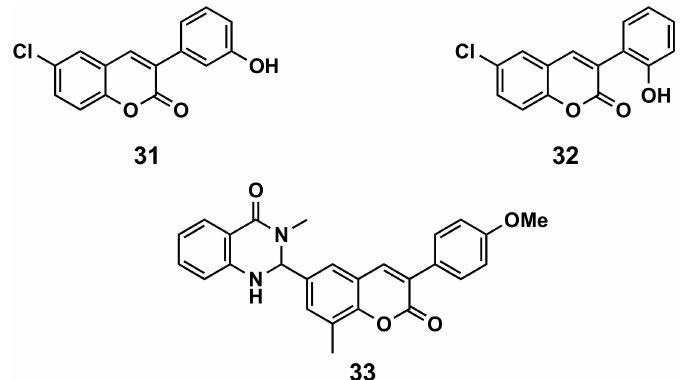
Figure 15. 3-Phenylcoumarins in cardiovascular